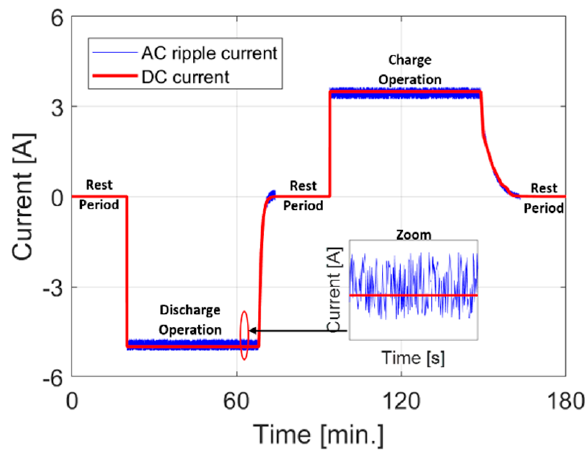
Figure 3. Example test signal as described in Section 3.2, showing a DC signal with a superimposed AC cycle (for illustrative purposes).